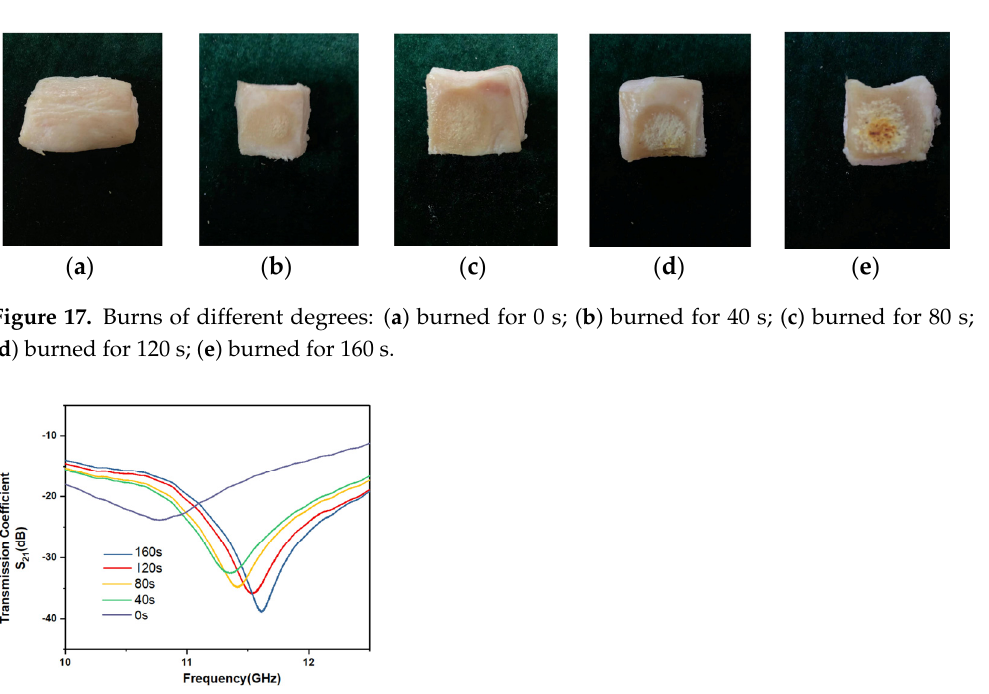
Figure 18. Measurement results of burns of different degrees.